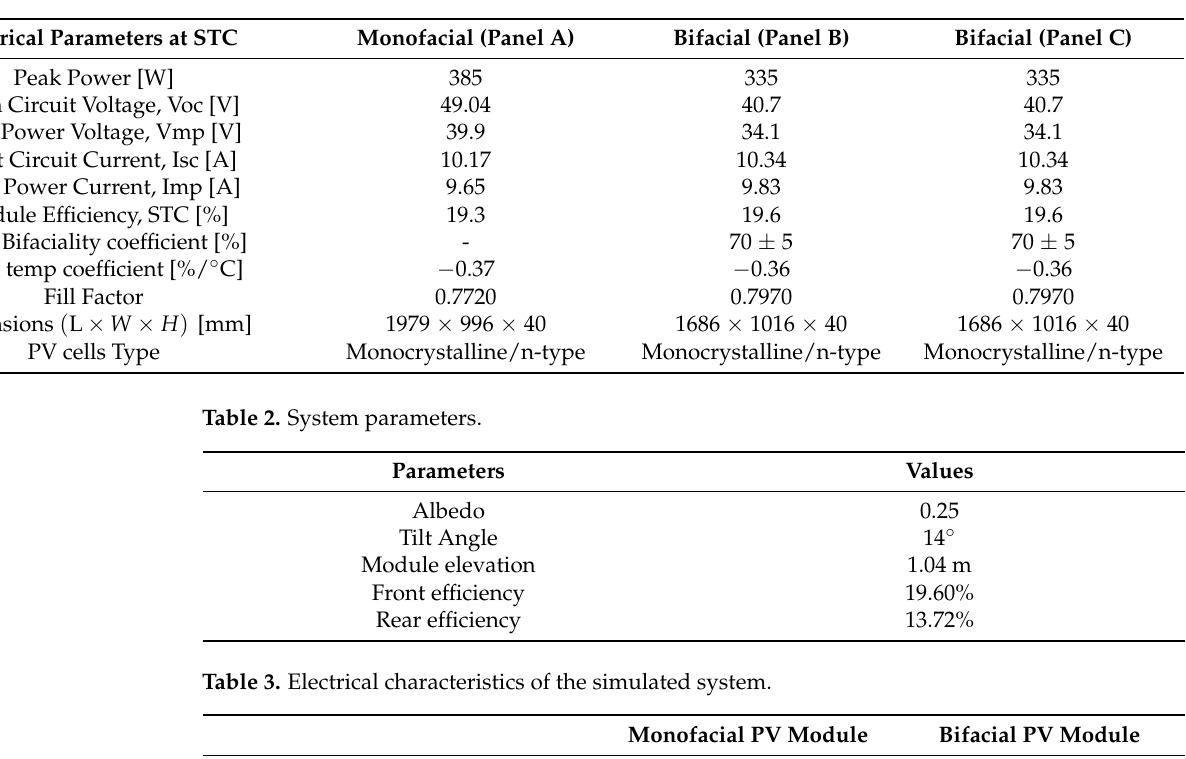
Table 1. Electrical characteristics of the experimental setup at Navrongo.